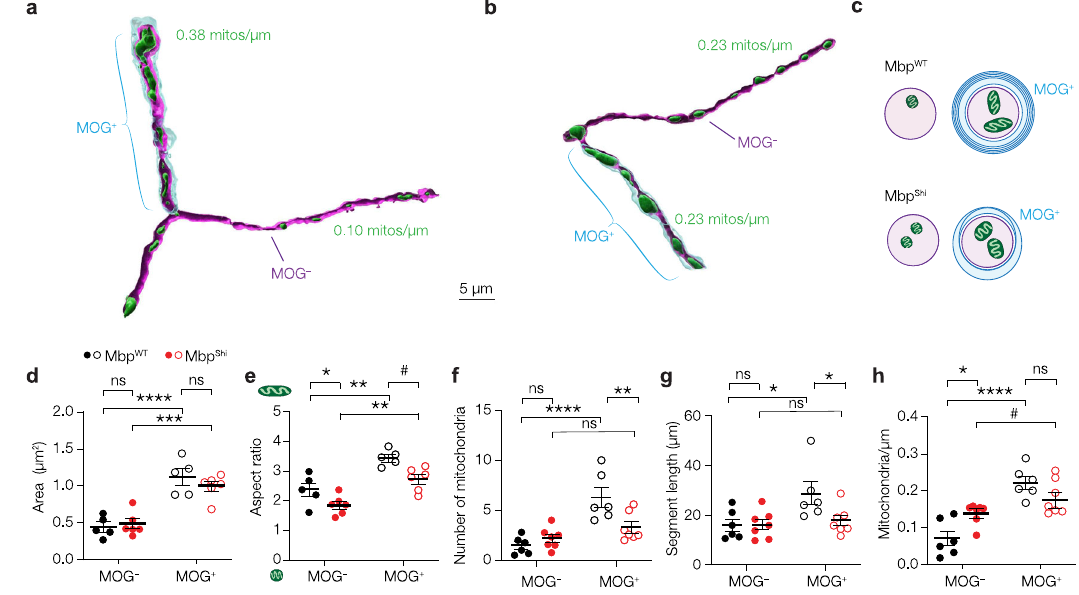
Fig.6|Noncompactedmyelinsuf fi